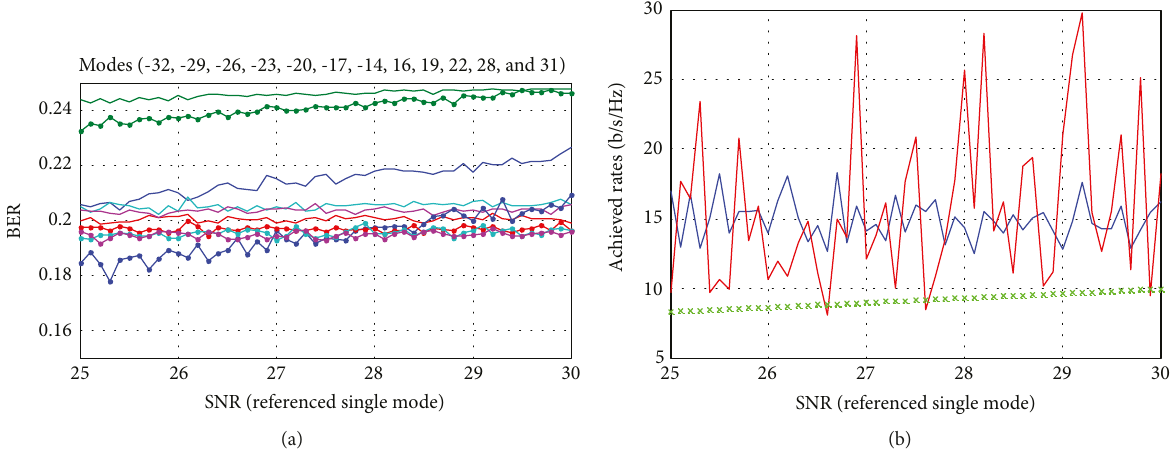
Figure 4: (a) Selecting high-leakage modes ( − 32, − 29, − 26, − 23, − 20, − 17, − 14, 16, 19, 22, 25, 28, and 31) and plotting the BER-SNR curve for only fi ve modes. Some modes ’ performance in the partial-area receiver is better than that of the full plane. Dotted lines: partial plane; plain lines: full plane. Although performance is bad in terms of BER, achieved rates (in Figure 4(b)) are better at some points while using partial- area receivers (same parameters as Figure 3).